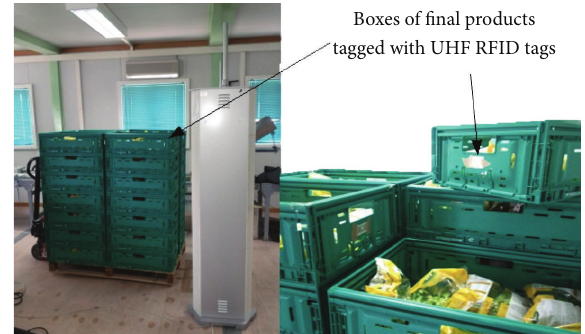
Figure 9: Pallet configuration during the first experimental cam-